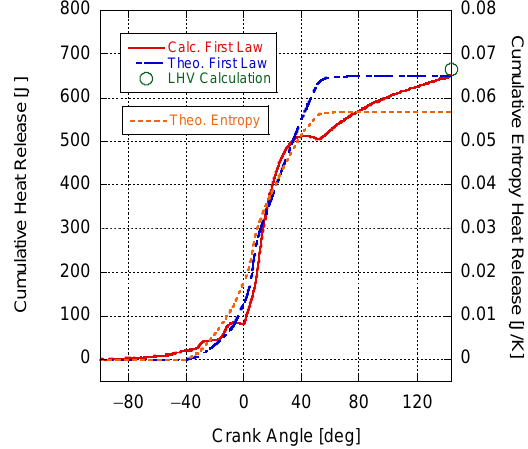
Figure 12. Cumulative heat release calculated based on the first law, from theory, and the final value according to the lower heating values with the theoretical entropy heat release plotted on the second y -axis.